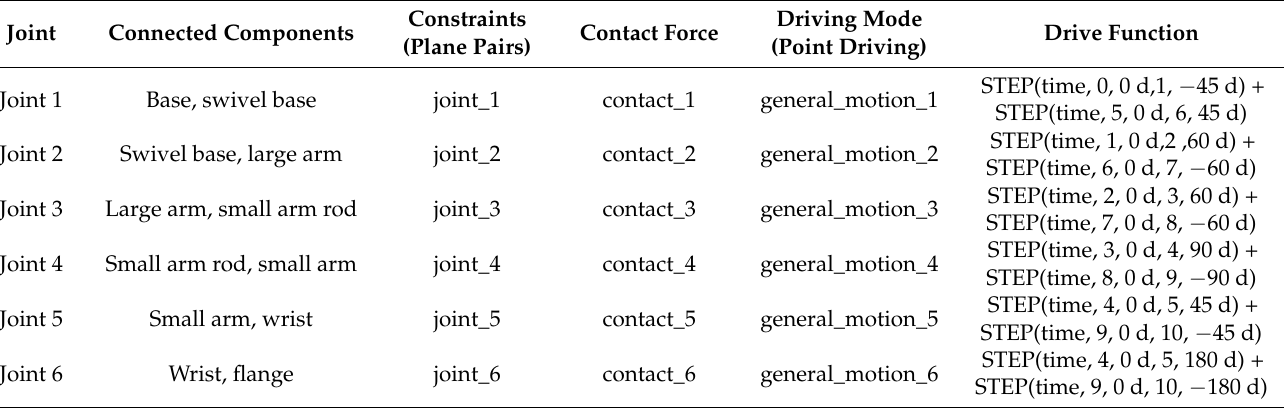
Table 3. Diagram of each joint constraint and drive parameter